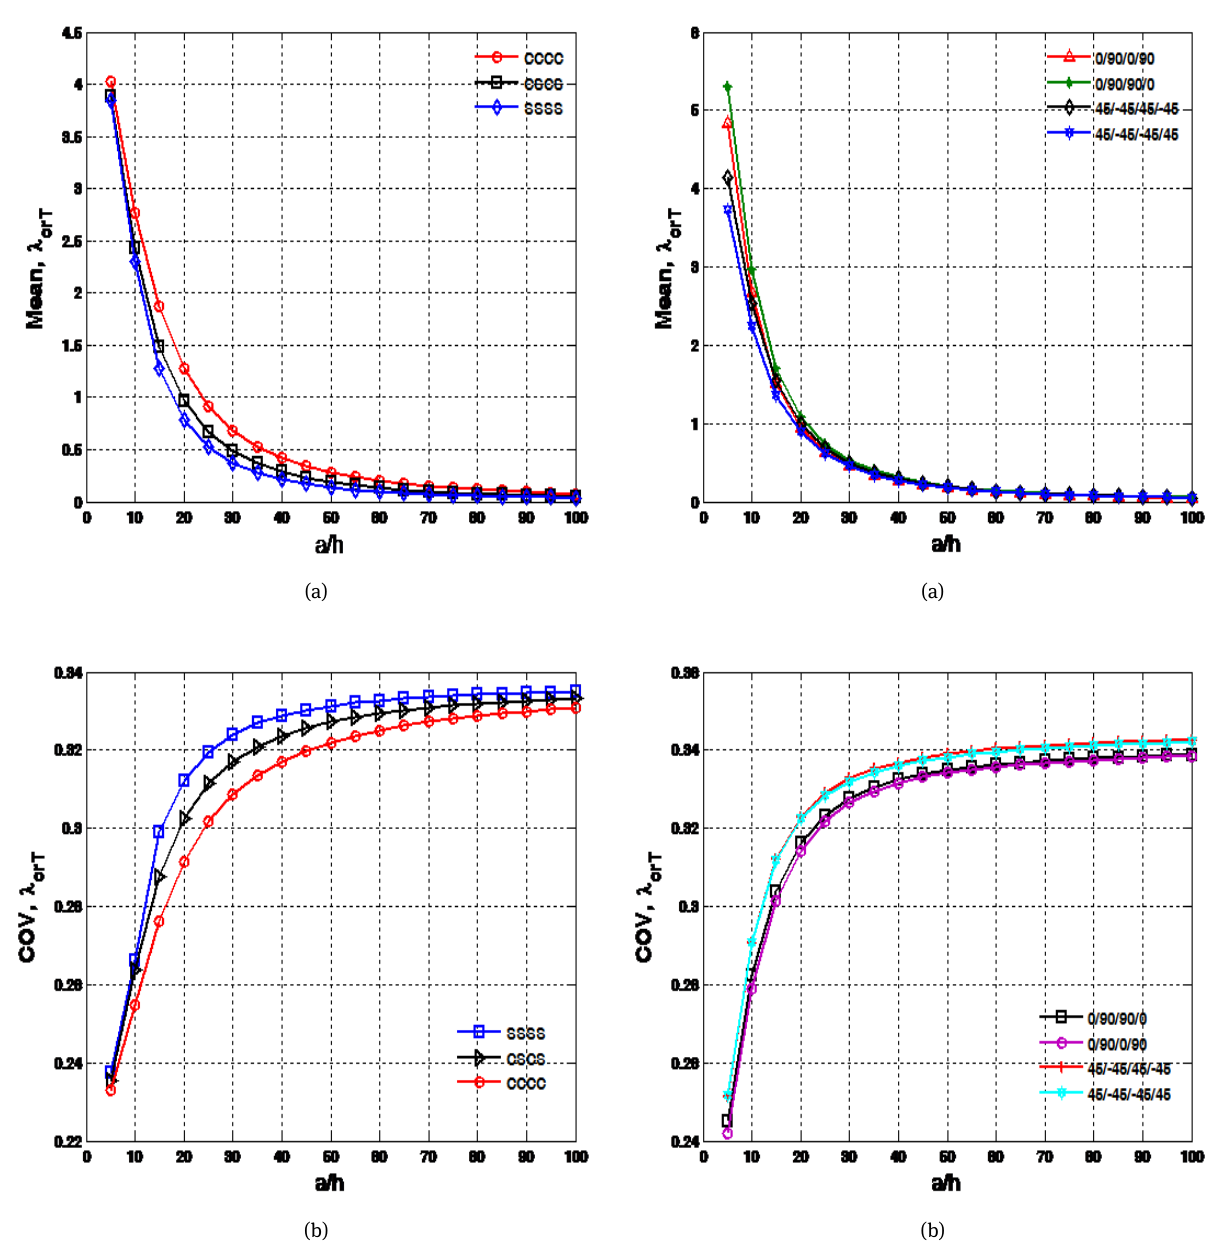
Figure 5: Efect of support conditions and plate thickness ratios with random change in all system parameres on the ( a ) mean and ( b ) COV of buckling temperature of square laminate plate.